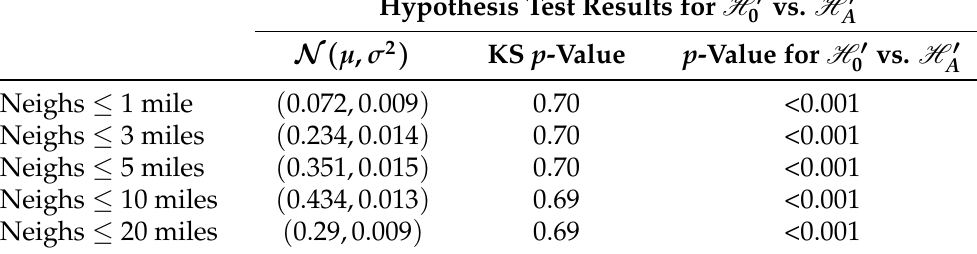
vs. H (cid:48) 0 A